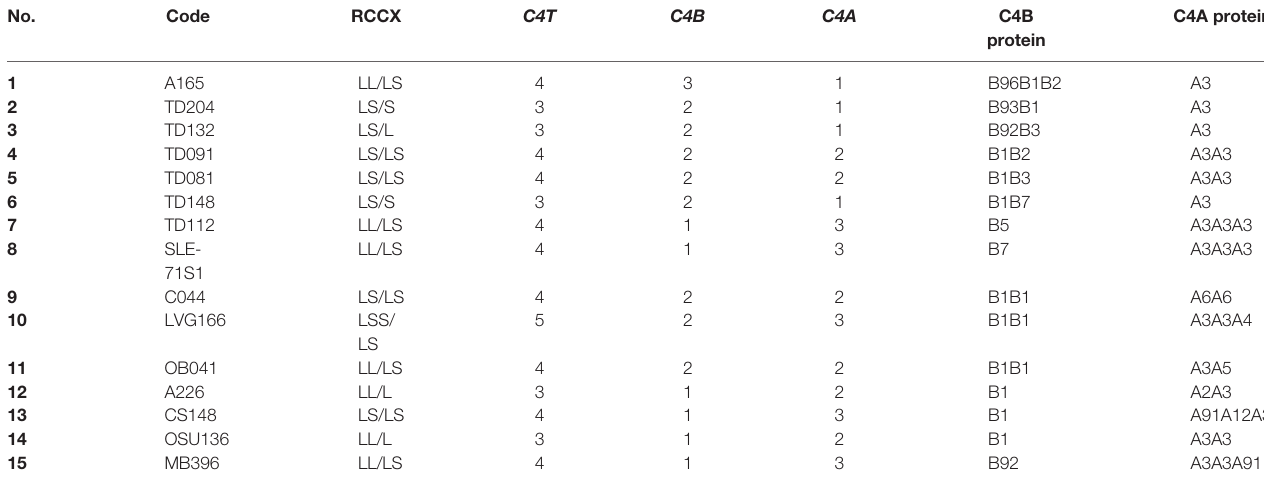
TABLE 1 | Genotypes and phenotypes of complement C4B and C4A for subjects shown in Figure 2 .